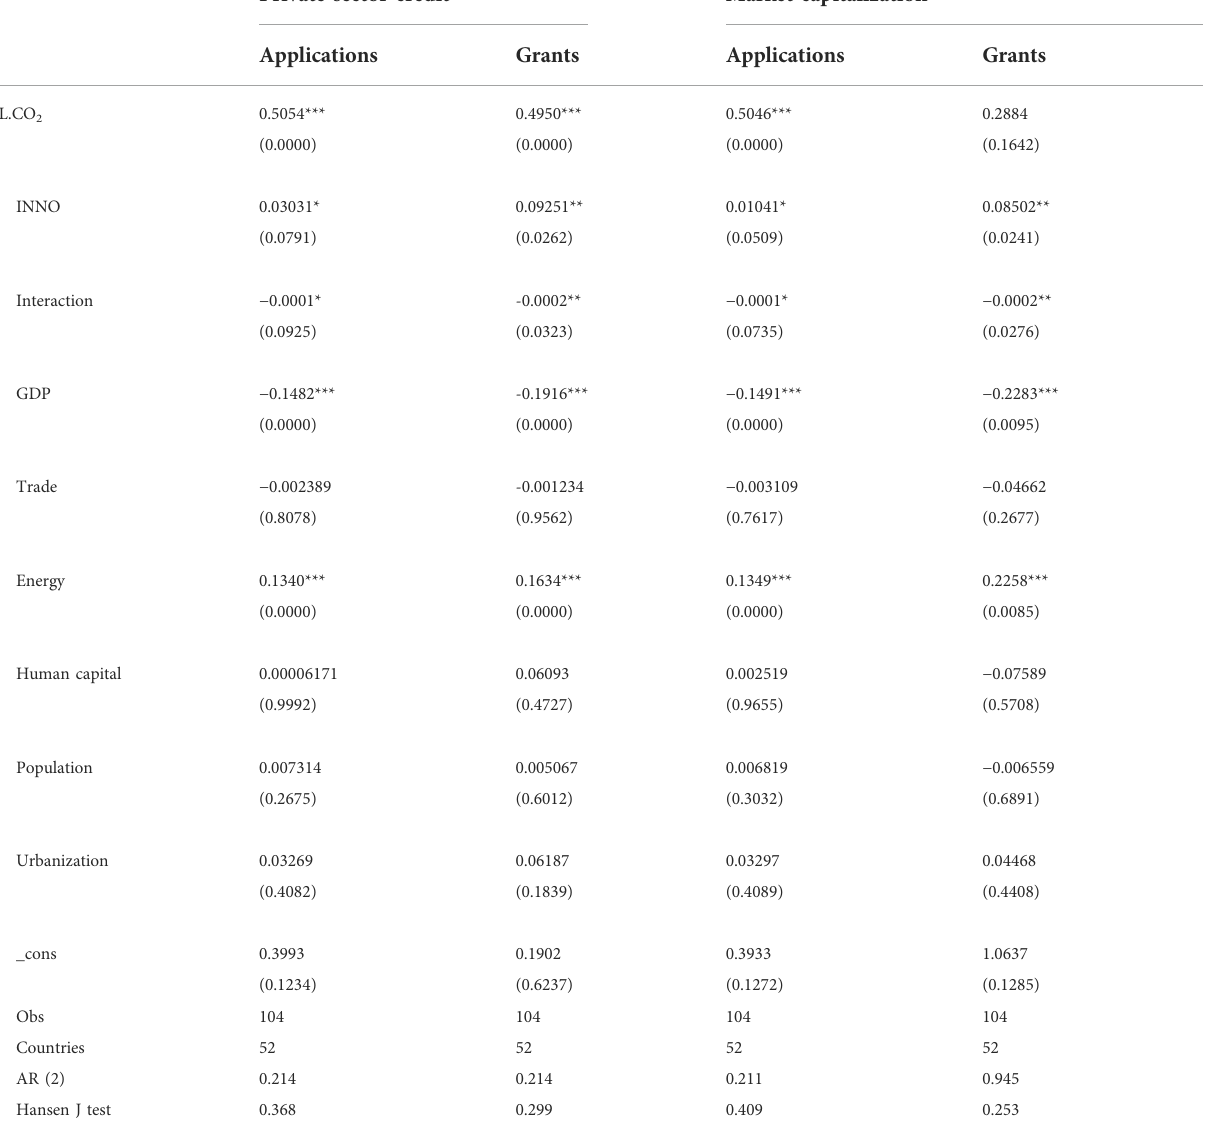
TABLE 6 The effect of innovation on environment quality with level of fi nancial development: 1990 –